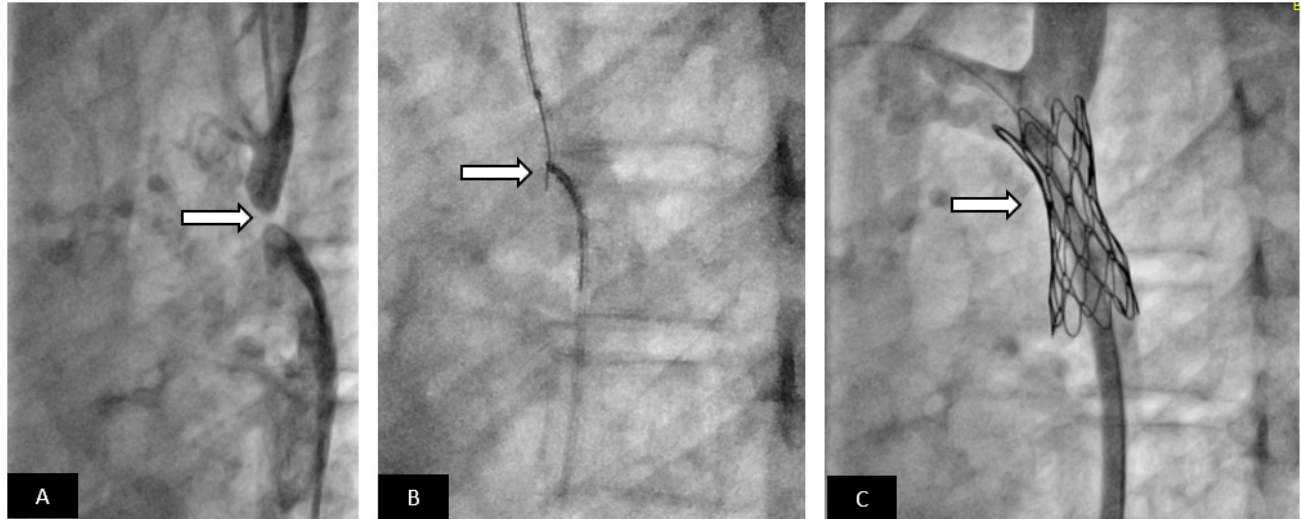
Figure 7. Covered stent for treatment of aortic coarctation with acquired atresia. Adolescent patient presented with severe systemic hypertension and exercise intolerance. ( A ) Lateral angiogram showing a short atretic segment (arrow). ( B ) A chronic total occlusion (CTO) guidewire is used to recanalize the atretic segment, a snare is placed in the distal aorta as a target for the CTO guidewire. Once the guidewire is snared, the segment is dilated with small angioplasty balloon. A long delivery sheath is placed. Using a pre-mounted covered stent increases the safety of the procedure compared to using a bare-metal stent. ( C ) Excellent angiographic result with a well-positioned covered stent without evidence of aortic wall injury; the patient had relief of systemic hypertension.